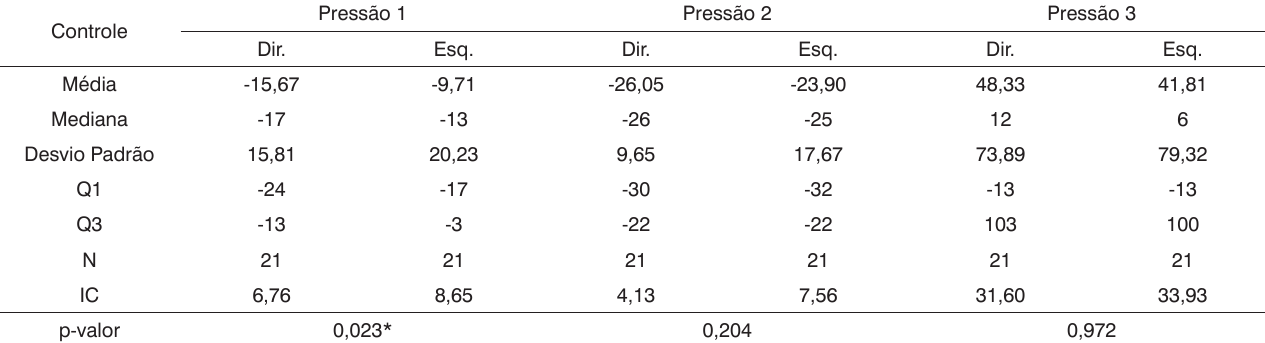
Tabela 2. Comparação lados da orelha à variação de pressão tuba auditiva do grupo controle